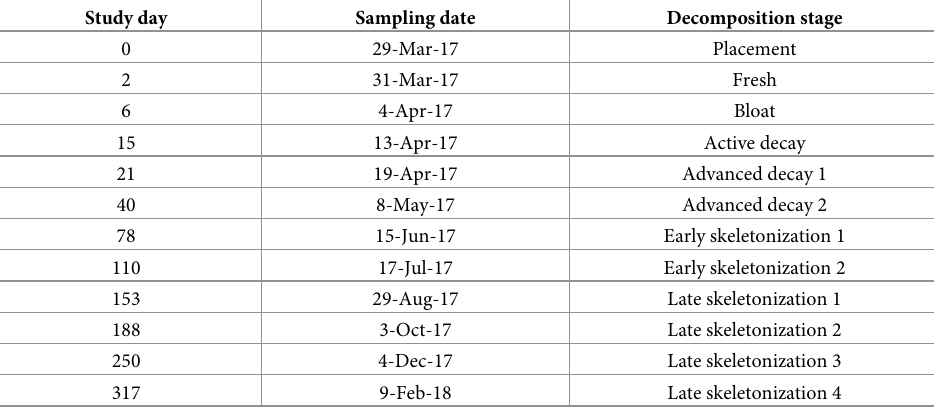
Table 1. Study day, sampling date, and morphological decomposition stage. Decomposition stages that include more than one sampling time point are numbered